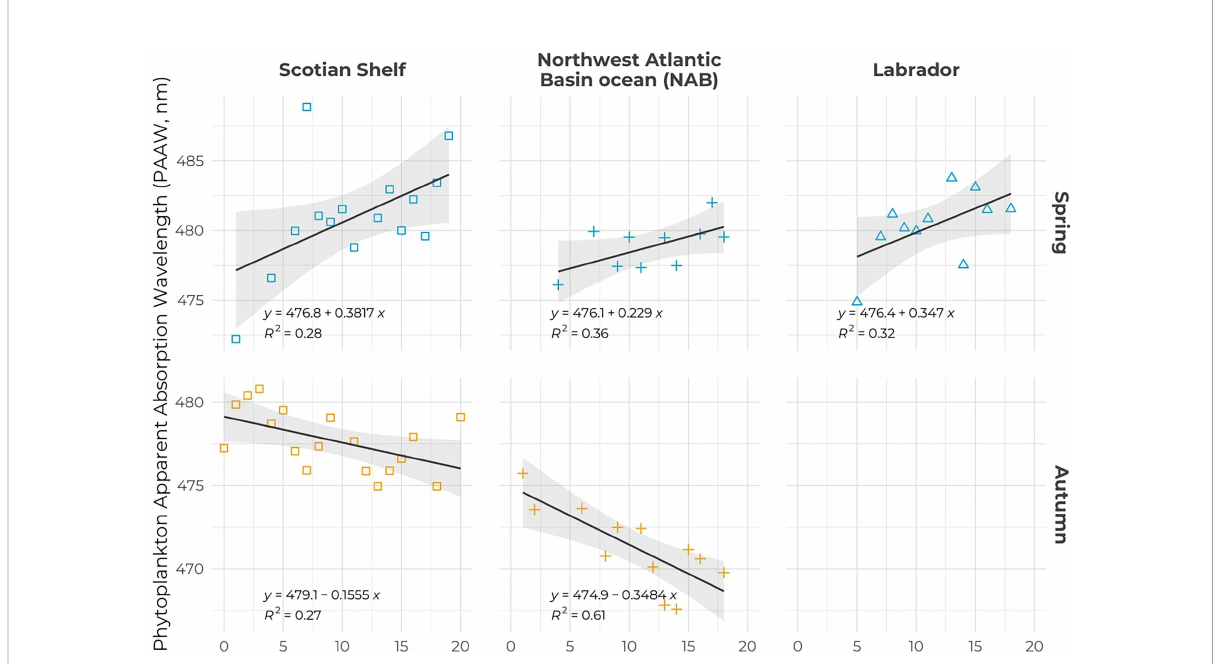
FIGURE 9 Seasonal trends in PAAW for spring (top panels) and autumn (bottom panels) for the Scotian Shelf (left), NAB (middle), and the Labrador Sea (right). The black solid lines correspond to the linear regression of PAAW against time with the coef fi cient and R 2 indicated in each panel. Symbols are color-coded according to season as in Figure